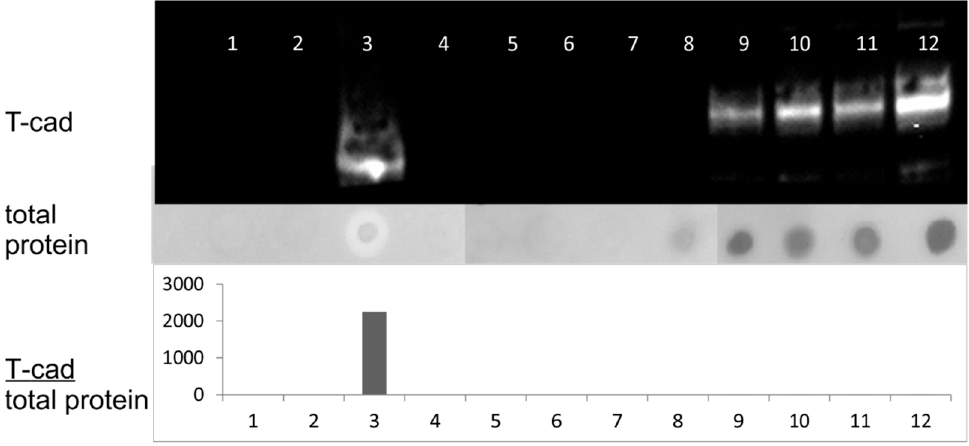
Figure 7. Analysis of fractions after ultracentrifugation of platelet lysates with the Triton X-114